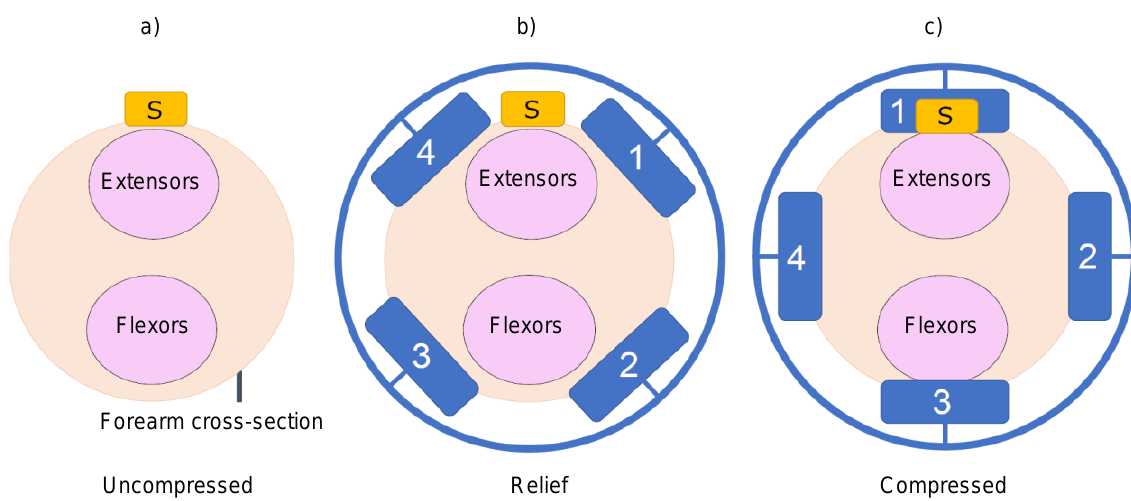
Figure 2: Experimental conditions tested. The approximate location of the wrist extensors and flexors are shown relative to the positions of the rig during the different data acquisition configurations and the corresponding locations of bar 1, 2, 3 and 4. “S” represents the location of the EMG electrode throughout all three configurations. (a): Uncompressed configuration; (b): Relief configuration; (c): Compressed